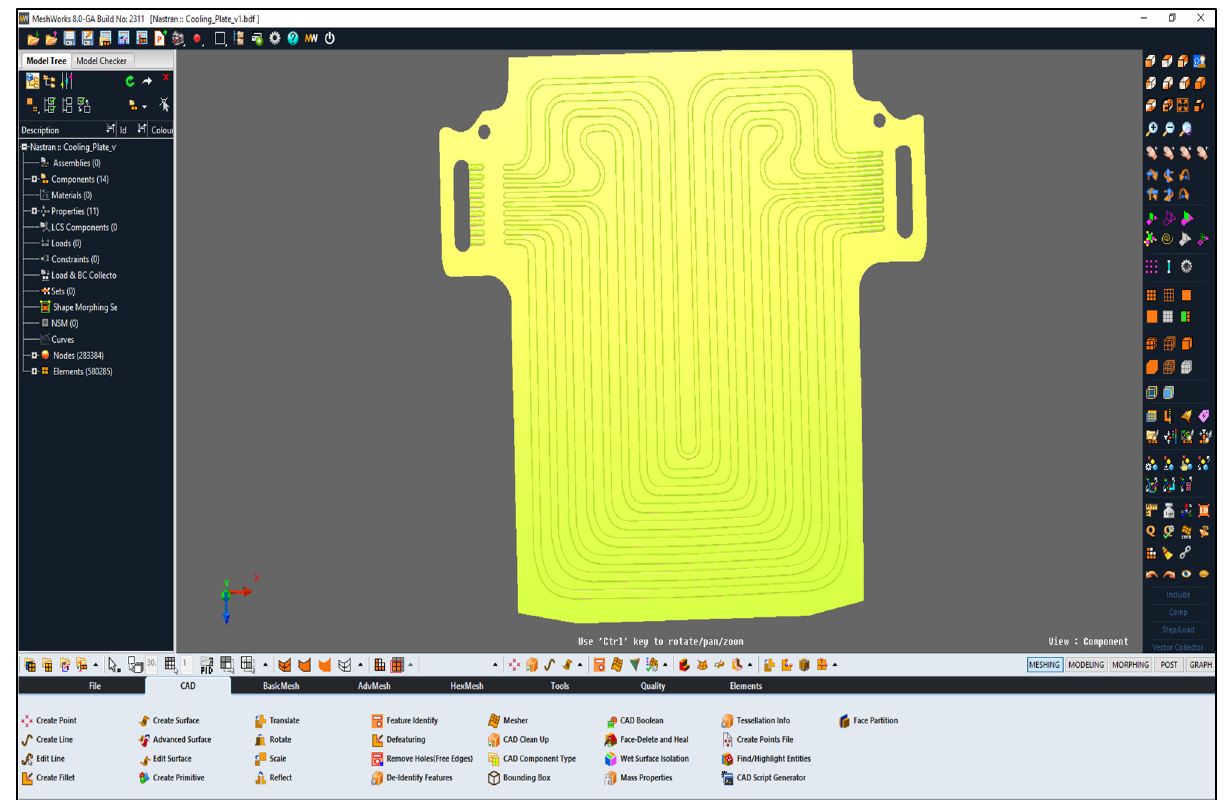
Figure 4. DEP MeshWorks 8.0 screenshot during meshing of cold plate.